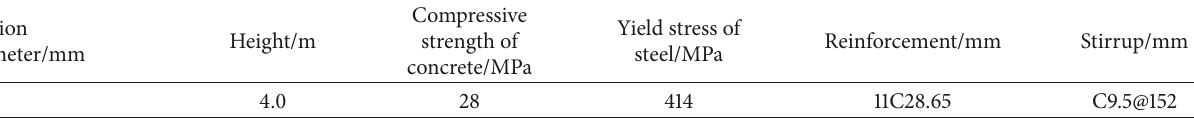
Table 6: Design values of bride pier [2].